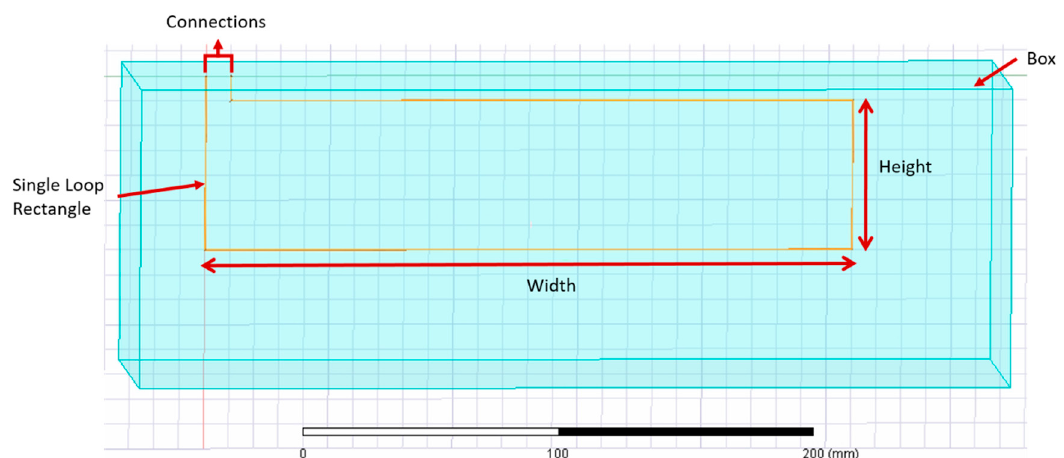
Figure 10. Single loop rectangle simulated in Ansys for Sections 4.1 and 4.2.